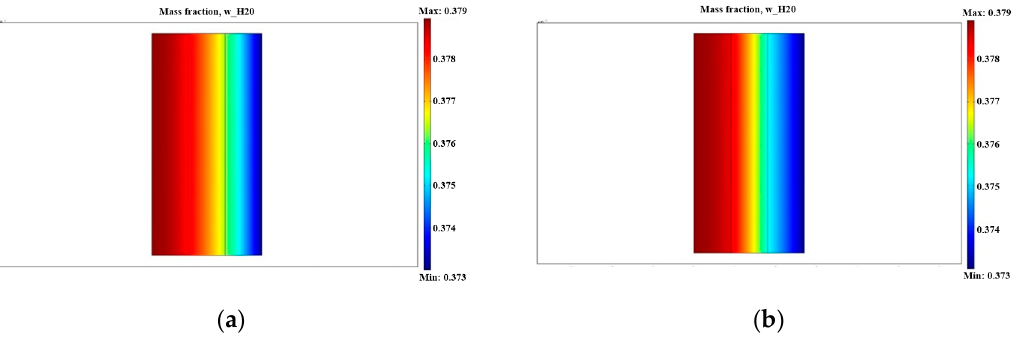
Figure 2. Comparison of water mass fraction in the traditional catalyst layer and trilaminar-catalytic layer: ( a ) traditional catalyst layer; ( b ) trilaminar-catalytic layer.